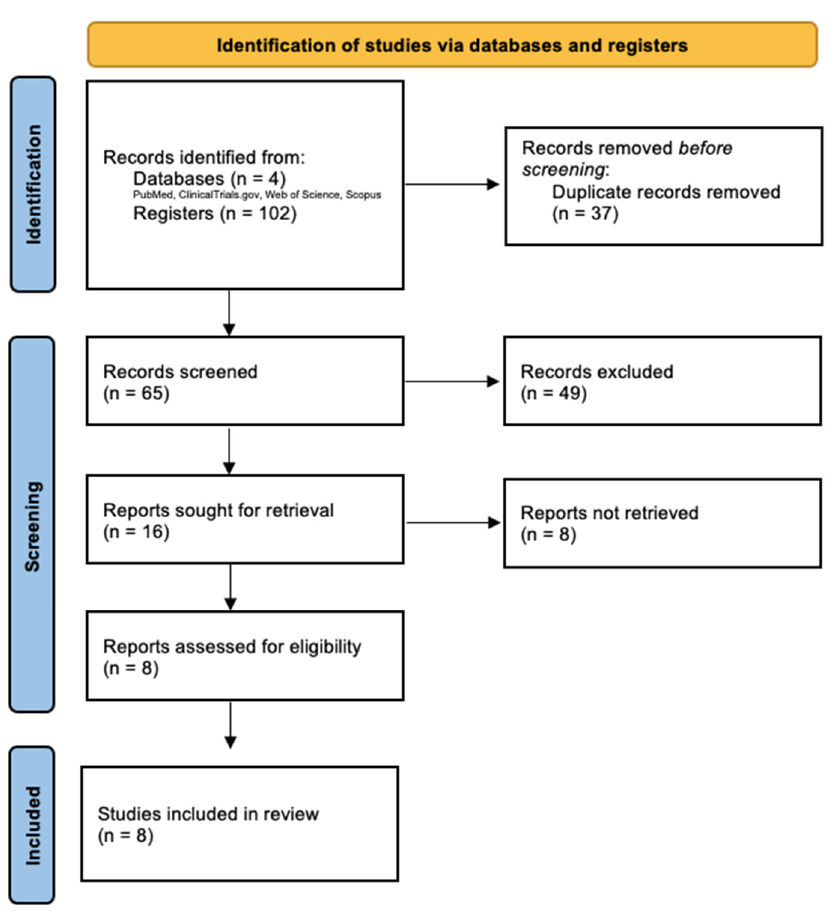
Figure 1. PRISMA flow-diagram of database search, study selection and included studies in this systematic review with meta-analysis.